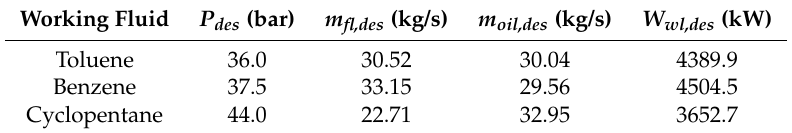
Table 3. ORC power plant data in design conditions—parameters depending on working fluid. Working Fluid